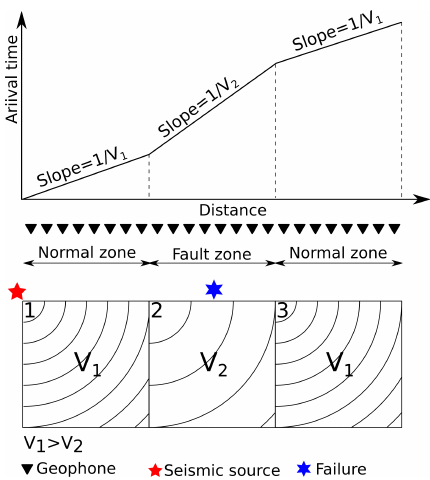
Figure 5. Conceptual sketch of propagation of direct seismic waves through a ground